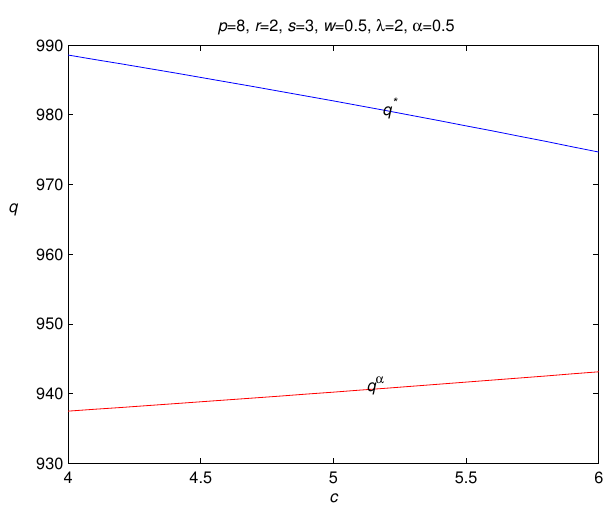
Figure 3. Optimal order quantities q ∗ and q α with different wholesale price c